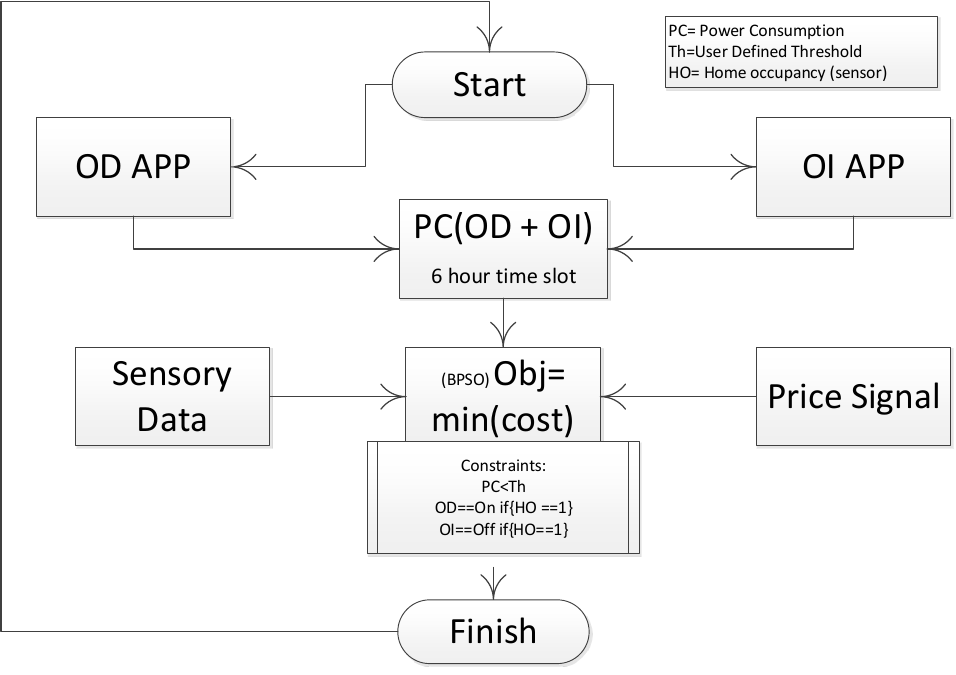
Figure 3. Flow diagram: Scenario